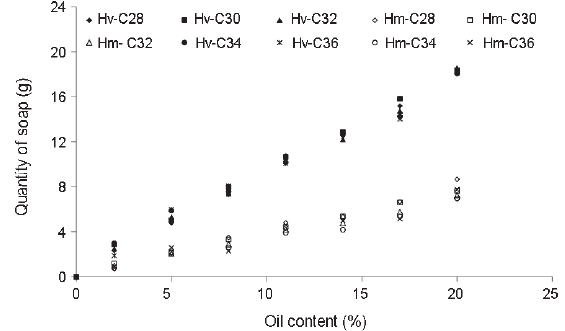
Fig. 15. Evolution of soap quantity as a function of oil content